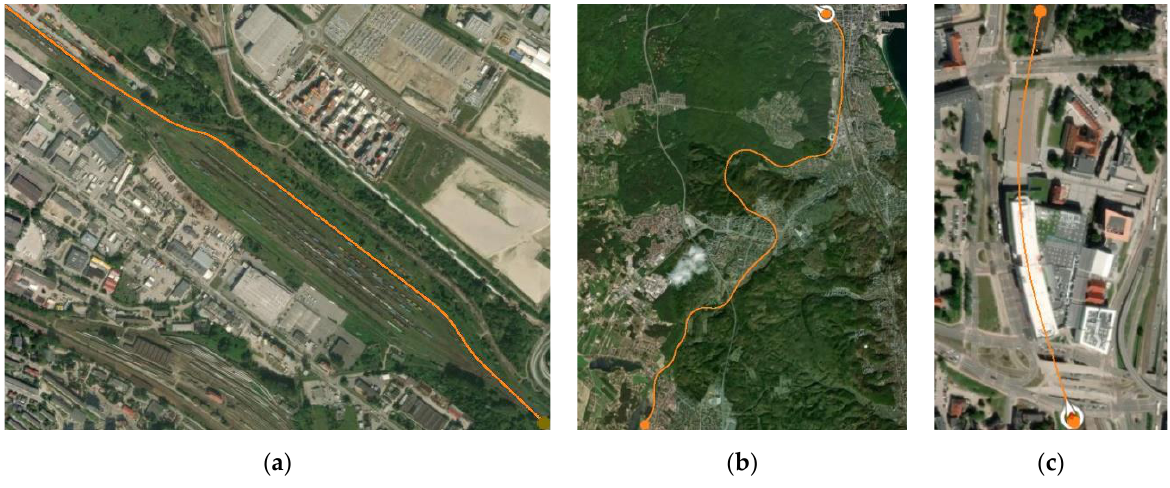
Figure 7. The division of the route into test sections: no. 1 ( a ), no. 2 ( b ) and no. 3 ( c ).